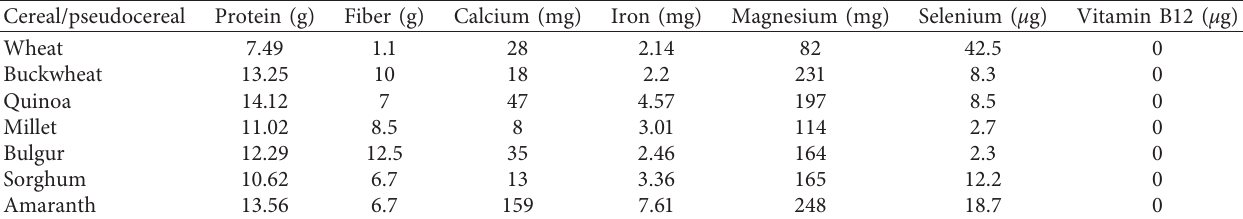
Table 1: Comparison of micronutrient composition between wheat and pseudocereals (in the National Nutrient Database for Standard